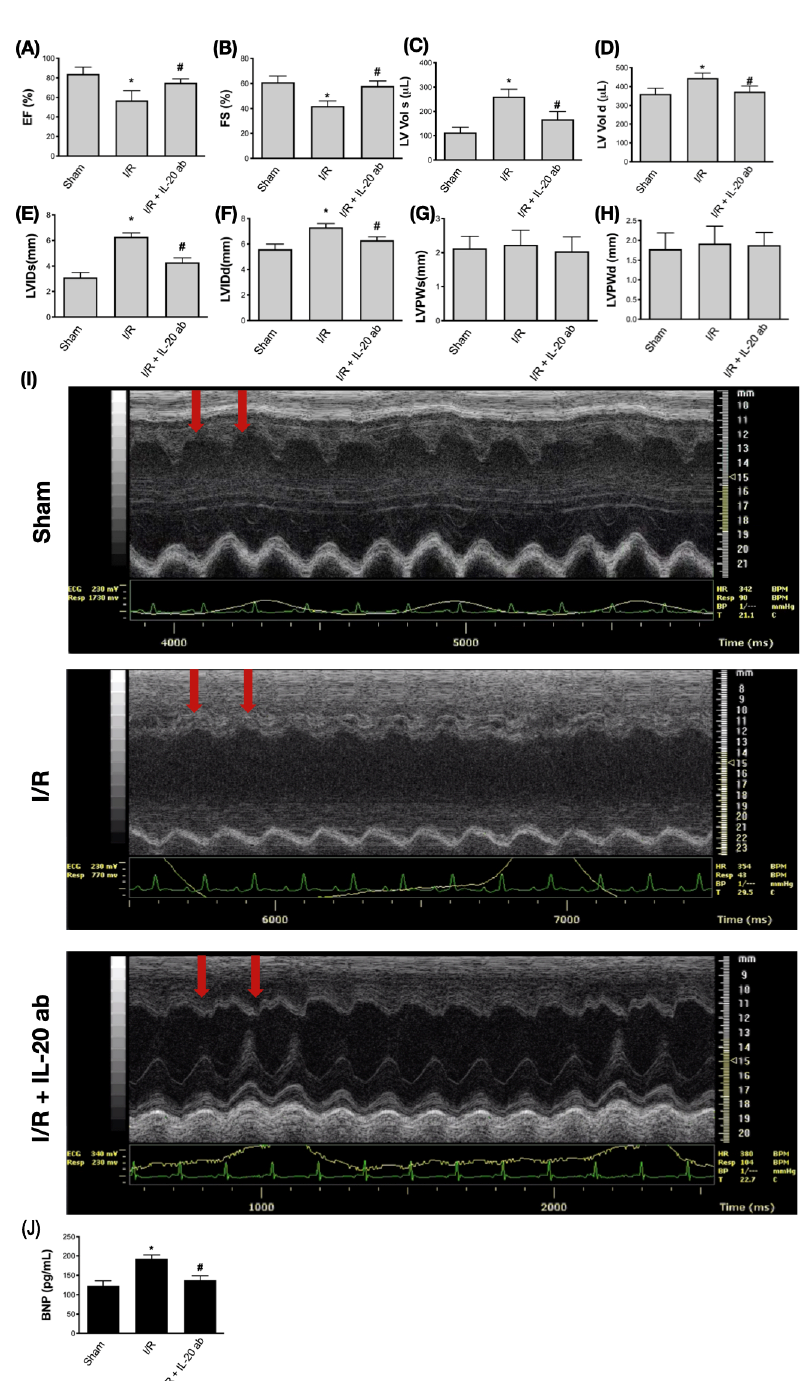
Figure 6. Examination of cardiac function using echocardiography. The parameters of the left ventricular function were measured using M-mode echocardiography. The ejection fraction (EF) ( A ) and fractional shortening (FS) ( B ) of left ventricle were measured to determine the left ventricular contraction ability. The volume of the left ventricle at end systole ( C ) and at end diastole ( D ), the internal dimension of left ventricle at end systole ( E ) and at end diastole ( F ), as well as the left ventricular posterior wall thickness at end systole ( G ) and at end diastole ( H ) were measured to determine the dilatation of left ventricle. Representative images of M-mode echocardiography were shown to demonstrate the rescue of ischemia/reperfusion (I/R)-induced cardiac dysfunction by interleukin (IL)-20 antibody treatment. Red arrows indicate the anterior wall of left ventricle ( I ). The concentrations of plasma B-type natriuretic peptide (BNP) were checked to determine the degree of cardiac dysfunction ( J ). The data were presented as the mean ± standard deviation of six animals in each group (* indicating p < 0.05 compared to the sham group; # indicating p < 0.05 compared to the I/R